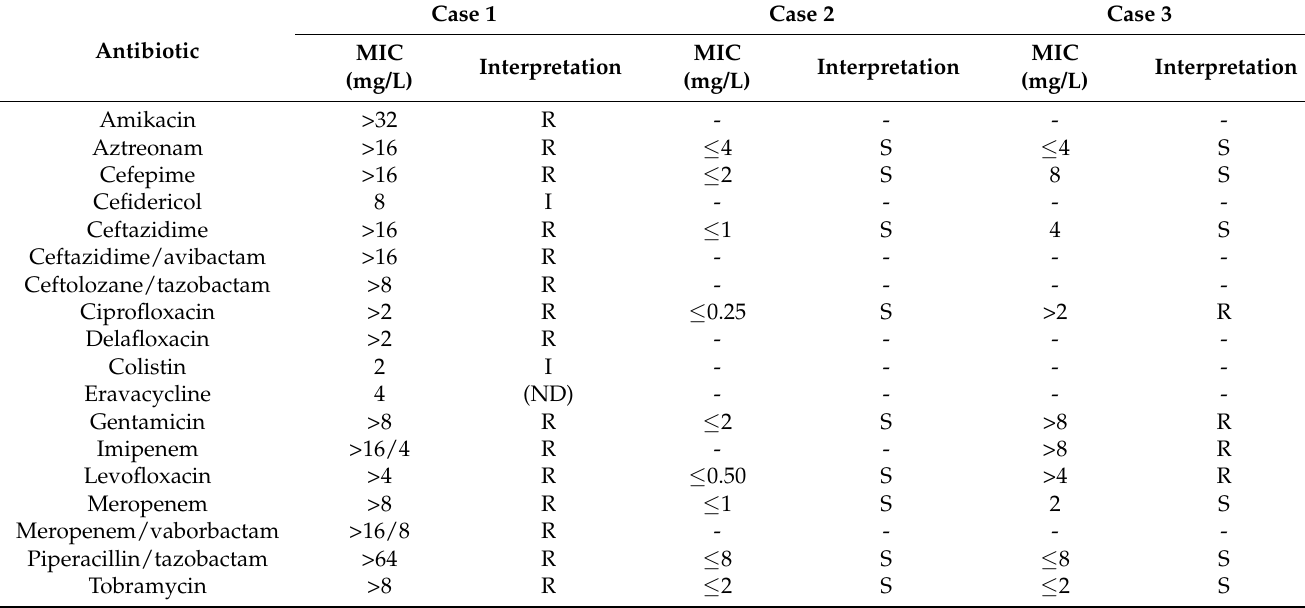
Table 1. Broth microdilution minimum inhibitory concentrations (MICs) for P. aeruginosa from strains isolated from ear canal (case 1) and sinuses (case 2 and case